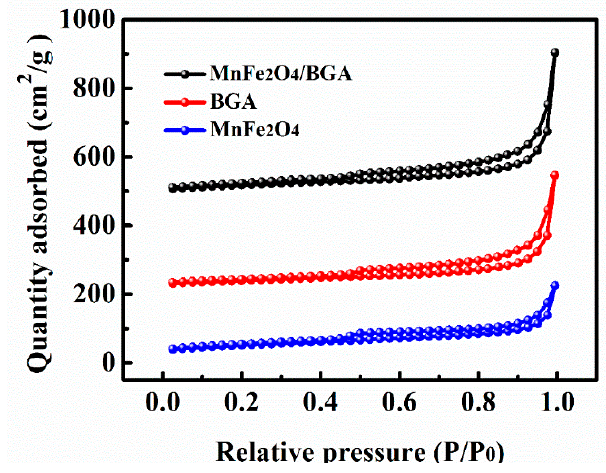
Figure 5. N 2 adsorption/desorption isotherms of MnFe 2 O 4 , BGA, and MnFe 2 O 4 /BGA. Shown in Figure 6a are the UV–vis DRS spectra of pure MnFe 2 O 4 and MnFe 2 O 4 /BGA, respectively. It is obvious that the MnFe 2 O 4 /BGA composite exhibits a much higher absorption band than pure MnFe 2 O 4 in the visible and near-IR regions, evidencing its enhanced absorption property for visible and near-IR light. Furthermore, in line with Figure 6b, the optical band gap of MnFe 2 O 4 /BGA composite is estimated to be 1.75 eV, which is smaller than that of pure MnFe 2 O 4 (2.09 eV). Thus, with the combination of BGA, the energy gap of MnFe 2 O 4 in the MnFe 2 O 4 /BGA composite narrows, which is beneficial to the generation and separation of the photo-induced electron-hole pairs, and eventually to the improvement in photocatalytic performance under visible light irradiation.